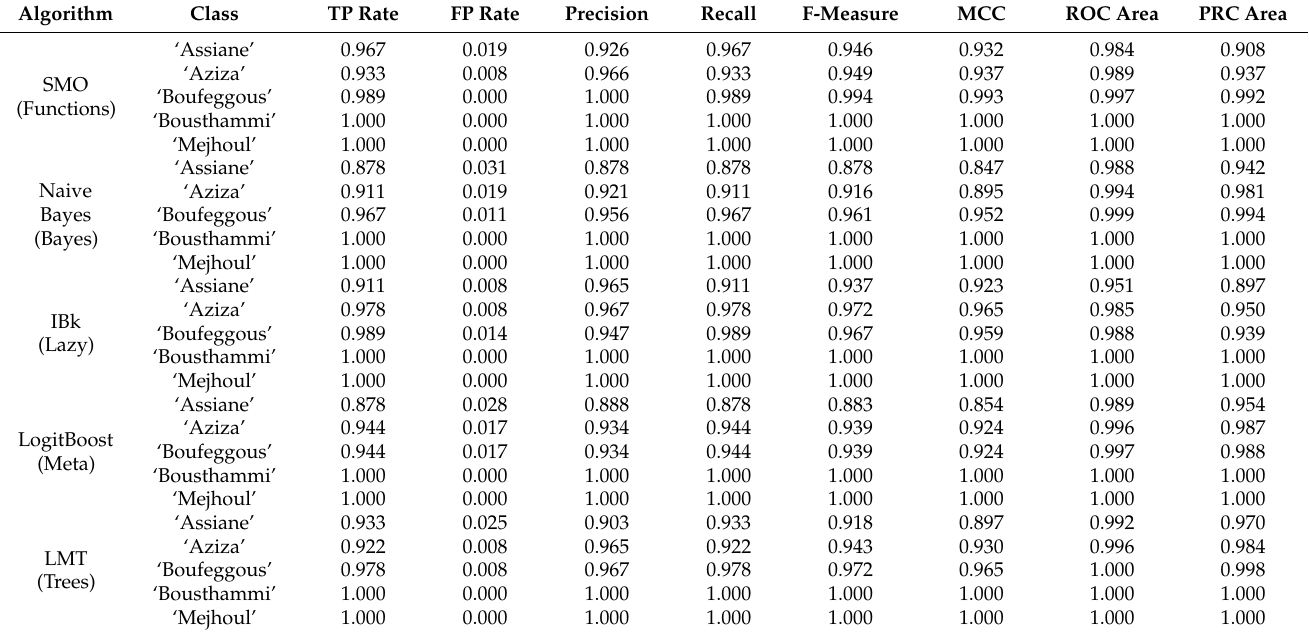
Table 2. Performance metrics of varietal discrimination of date palm fruits for the models built based on a set of image textures selected from color channels L , a , b , R , G , B , U , V , S , X , Y , and Z .